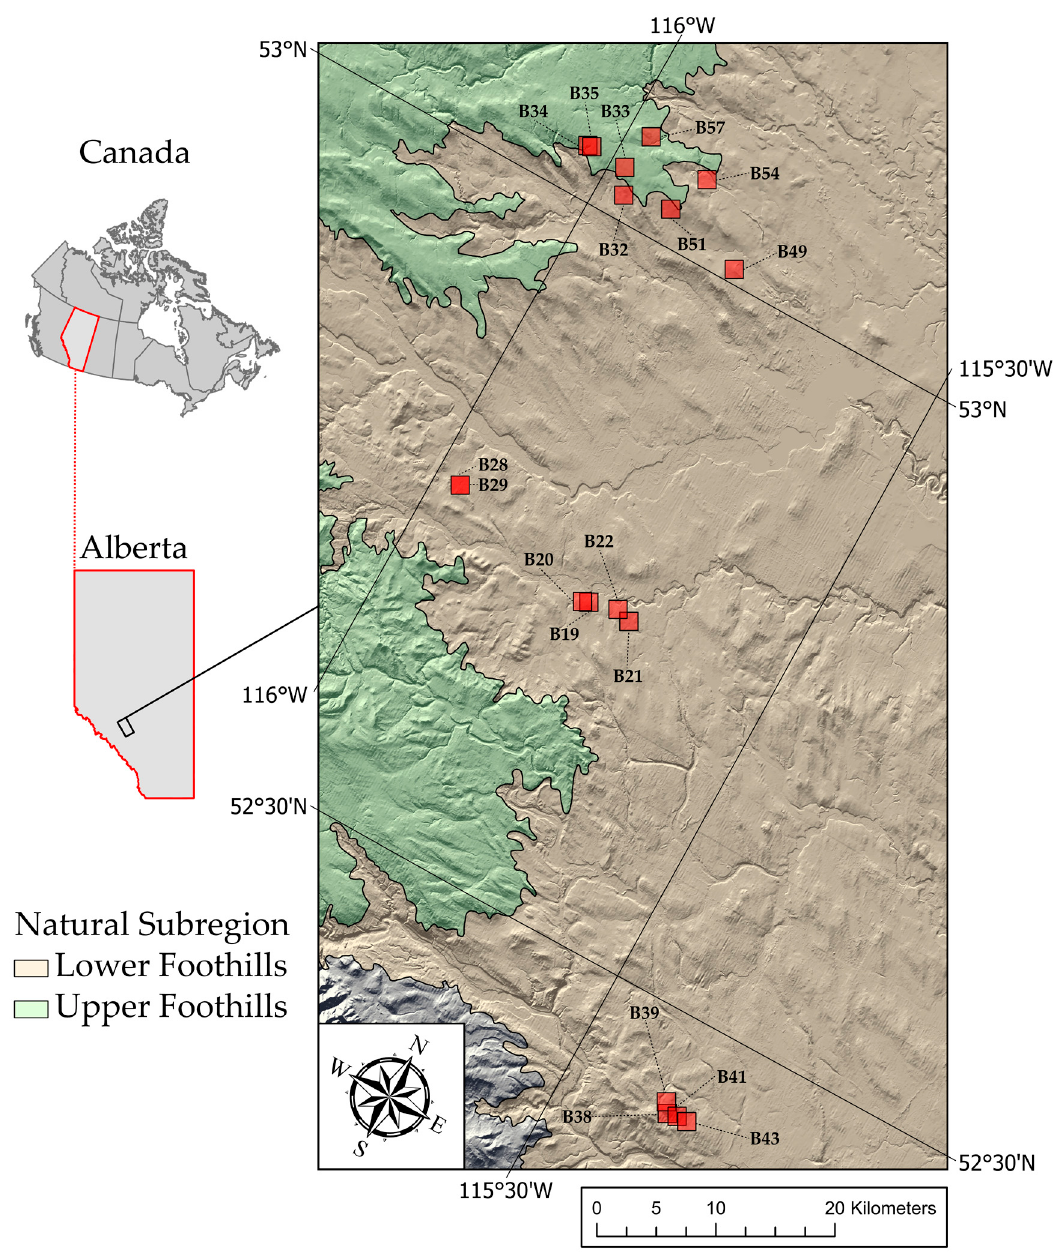
Figure 1. Location of the eighteen regenerating forest stands which formed the basis of this research. All sites are located in the Foothills Natural Region, which is divided into the Lower and Upper Foothills Natural Subregions.